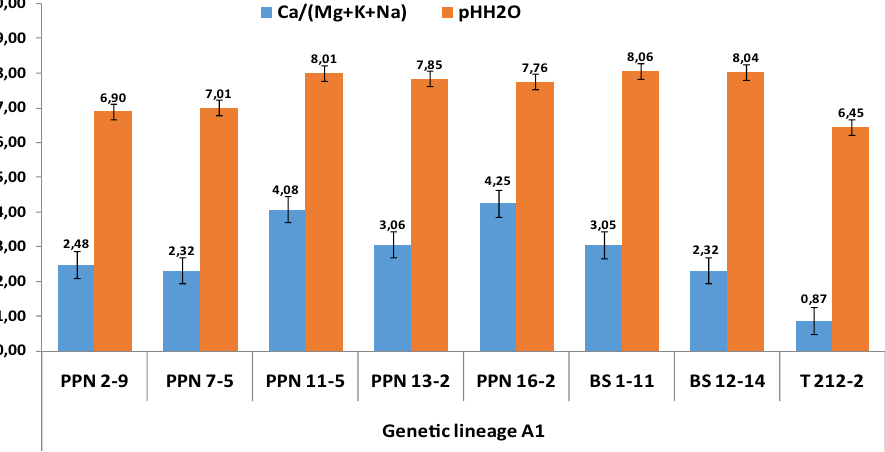
Figure 4. Singular site specific index of active forms of alkaline elements (Ca, Mg, K, Na) and pH in the growth media of A. pinguis cryptic species A genetic lineage A1 at Pieniny, Beskidy and Tatry Mts.